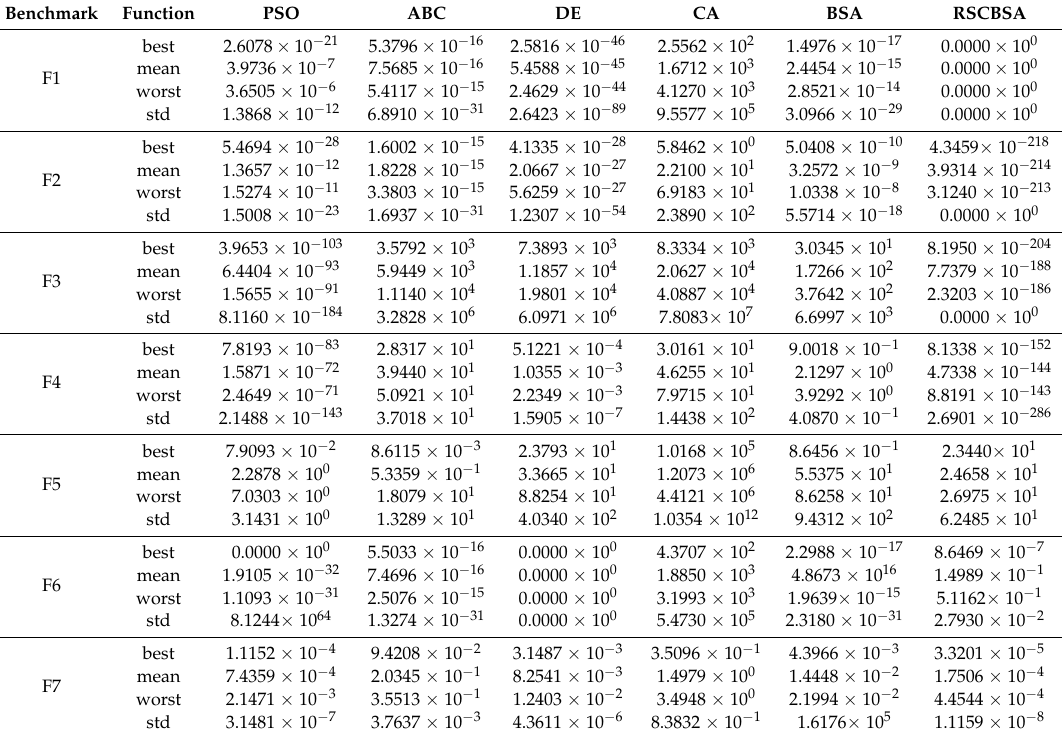
Table 1. Results of unimodal benchmark functions.